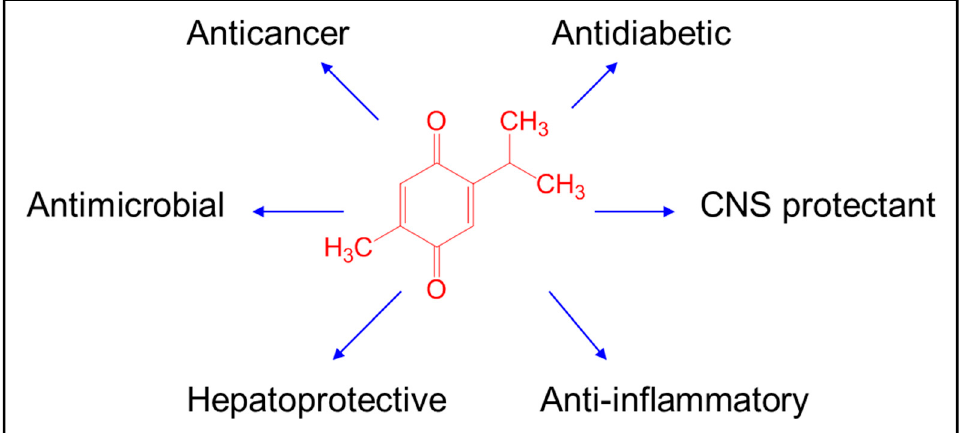
Figure 1. Biological activities of thymoquinone.